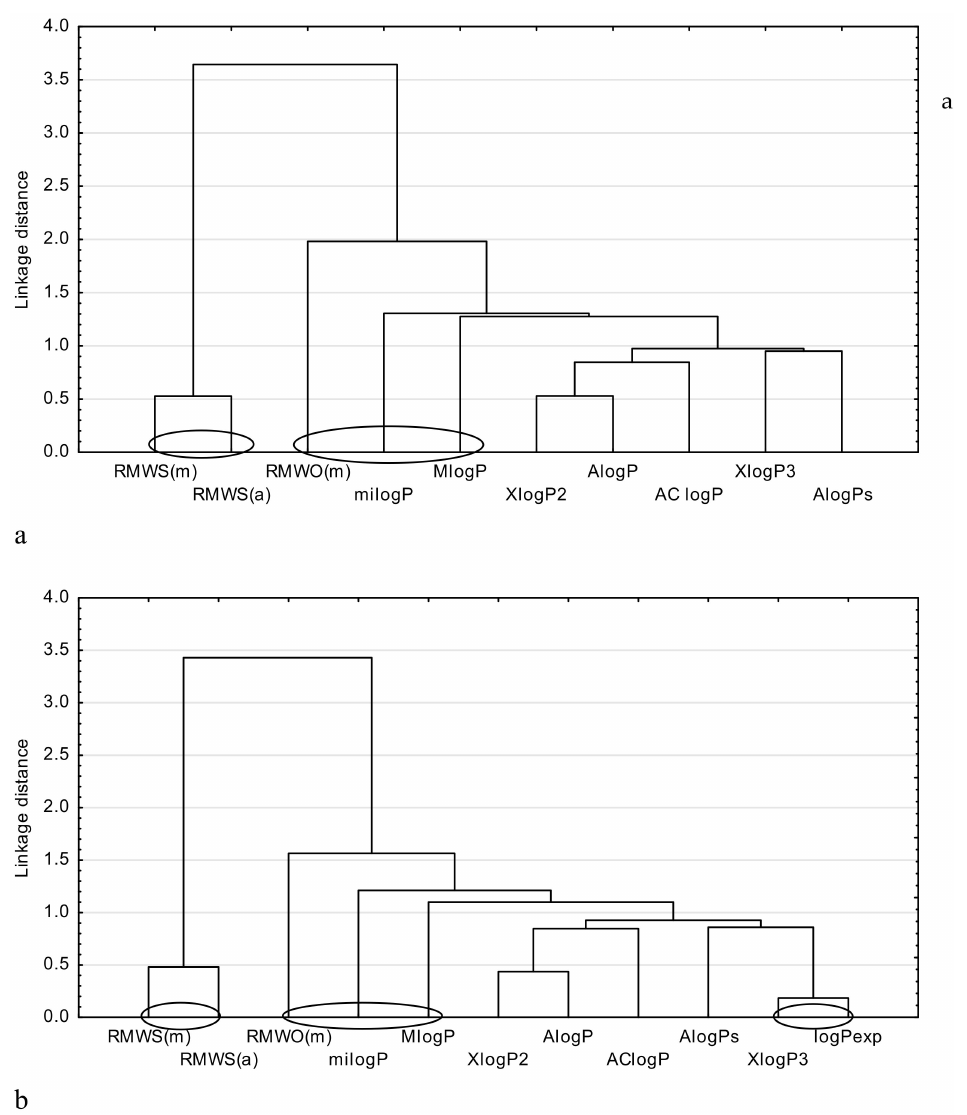
Figure 3. Similarity analysis for the examined NSAIDs, including: ( a ) comparison of the chromatographic and theoretical parameters of lipophilicity; ( b ) comparison of the